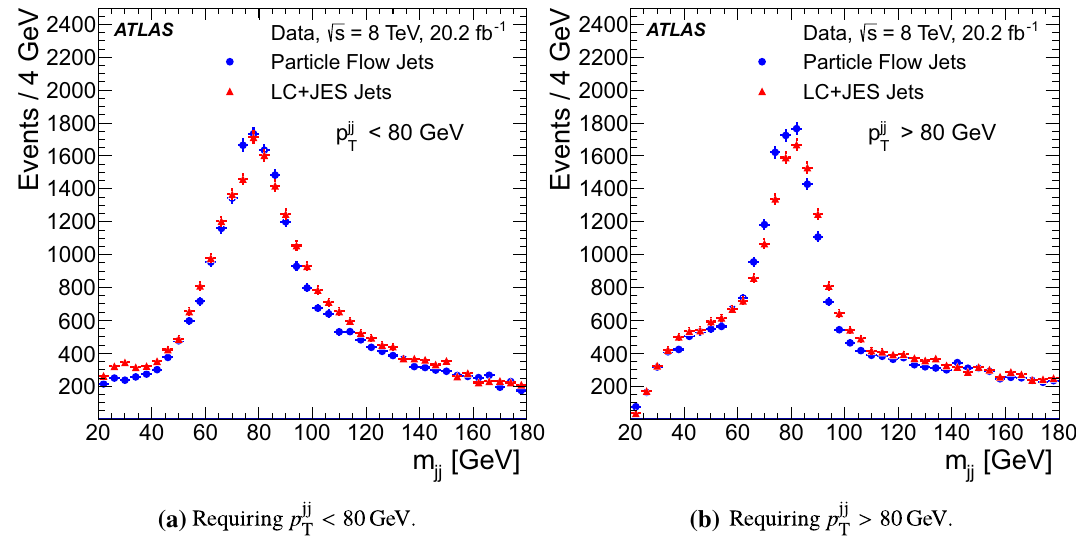
Fig. 37 Comparison between the m jj distributions measured using particle flow jets and calorimeter jets with a JVF selection in data. The sample is split into those events where the reconstructed W candidate has p jj